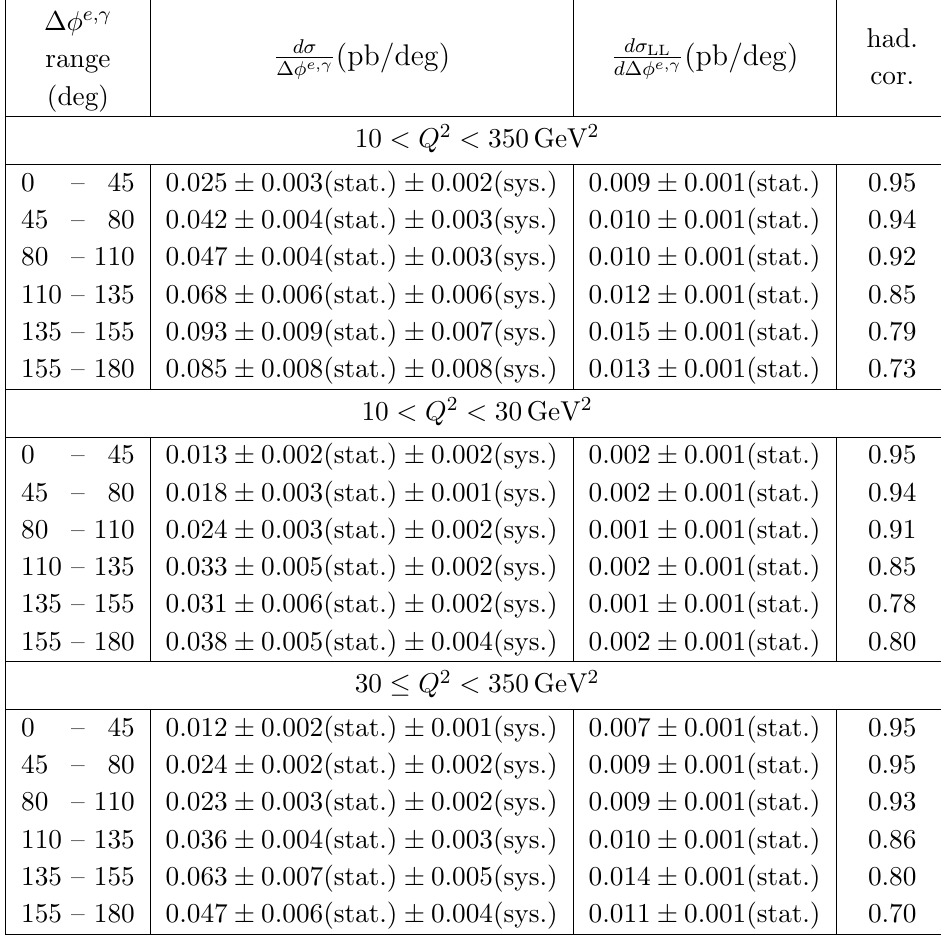
Table 5 . Measured di(cid:11)erential